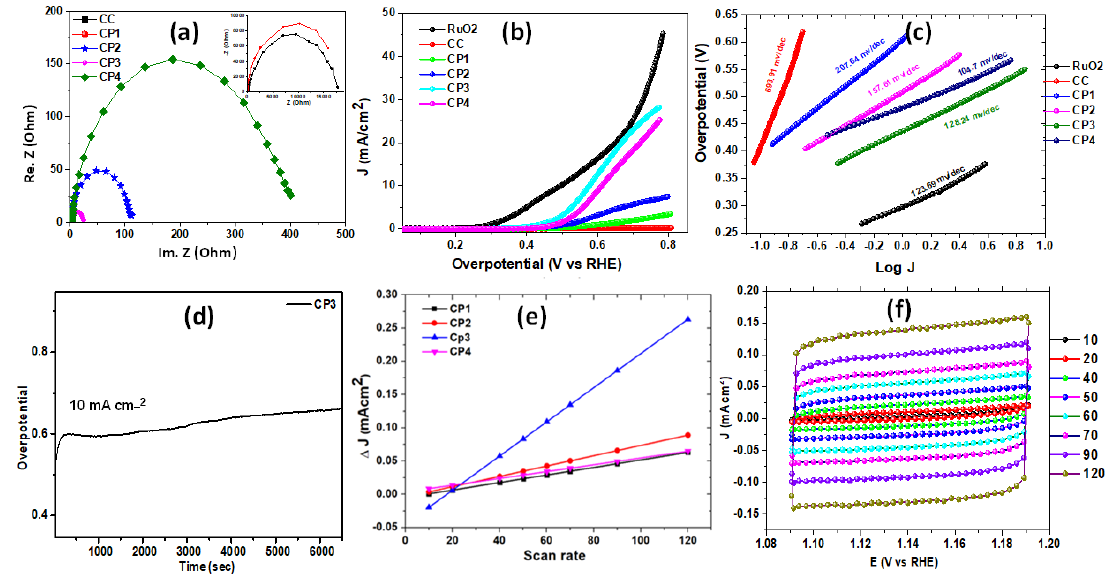
Figure 6. Oxygen evolution activities of the samples. ( a ) Nyquist plot; ( b ) polarization curve depicting the overpotential vs. current density of all samples; ( c ) Tafel plot; ( d ) stability curve of sample; CP3 ( e ) plot of the scan rate and current density; ( f ) CV curves for Cdl at different scan